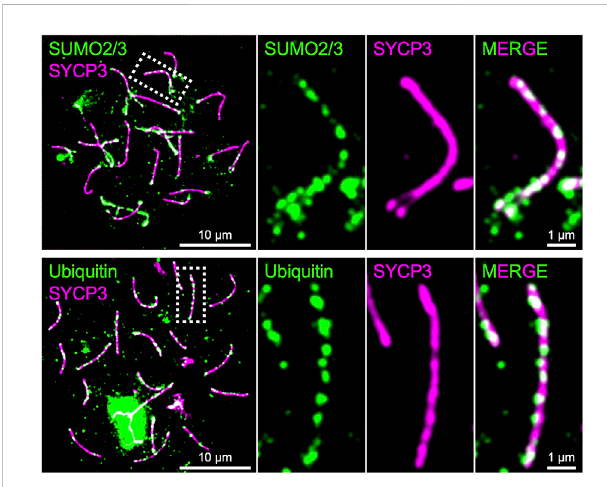
FIGURE 4 Chromosome axes decorated by SUMO and Ubiquitin in mice. Surface spreads of mouse spermatocyte chromosomes immunostained for SYCP3 (green) and SUMO2/3 (green; top) and Ubiquitin (green; bottom), respectively. Both SUMO and ubiquitin are enriched on chromosome axes where SYCP3